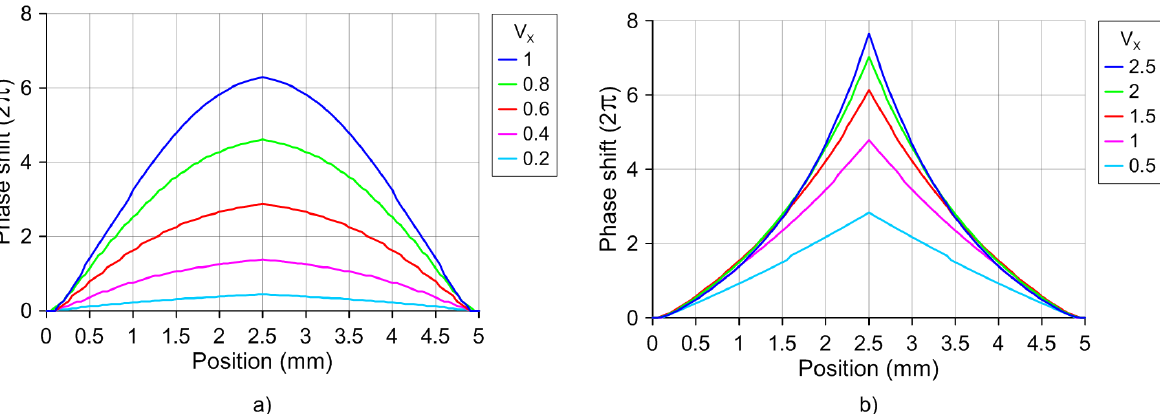
Figure 6. Phase shift profile in the XZ plane, for ( a ) lensacons; and ( b ) logarithmic axicons.